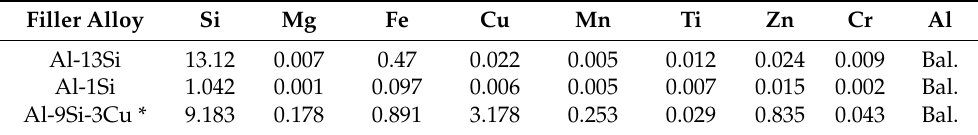
Table 1. Compositions of the filler alloys using an optical emission spectroscopy (wt.%). Filler Alloy Si